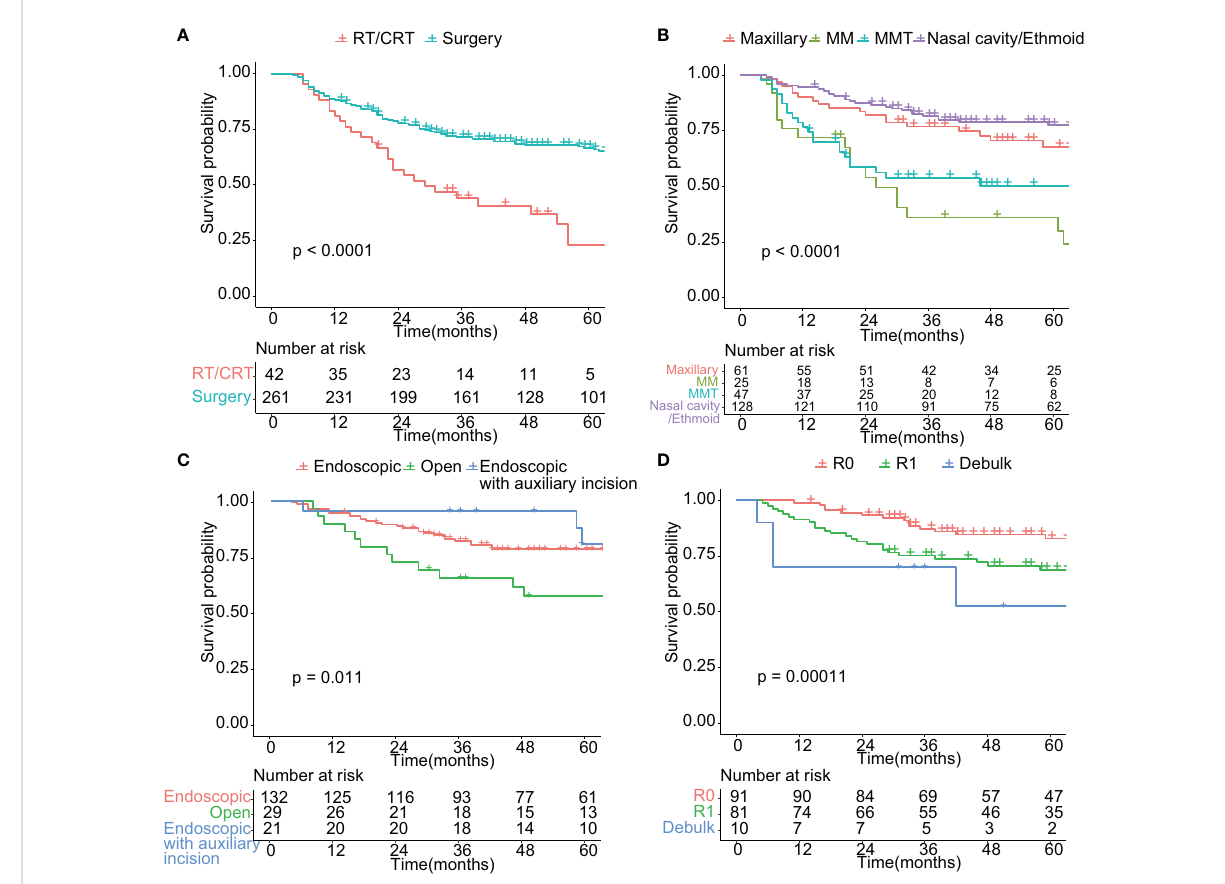
FIGURE 3 Comparison of overall survival in patients treated by different modality. (A) Comparison of overall survival of patients treated by surgery or radiotherapy/chemoradiotherapy ( p < 0.01). (B) Comparison of overall survival of patients with different tumor site ( p < 0.01). Maxillary: